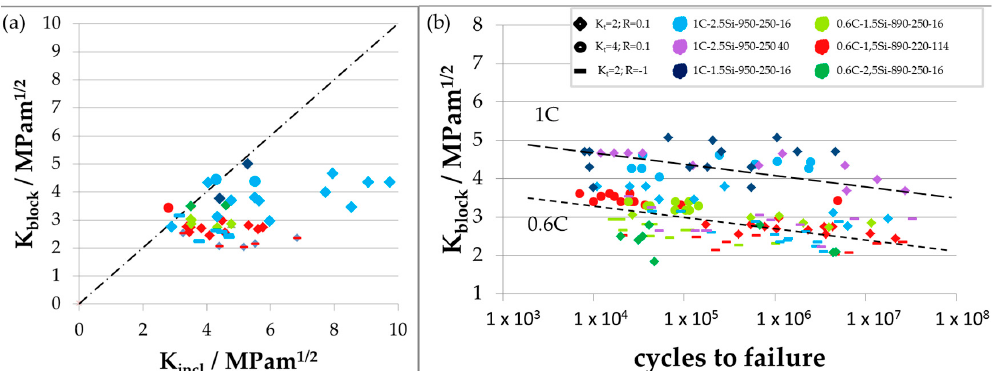
Figure 12. ( a ) SIF at nonmetallic inclusions plotted against SIF at crystallographic bainite blocks; and ( b ) SIF at crystallographic bainite blocks plotted against cycles to failure. The two dotted lines represent two groups of SIF with a linear decreasing trend, which are formed in the diagram.